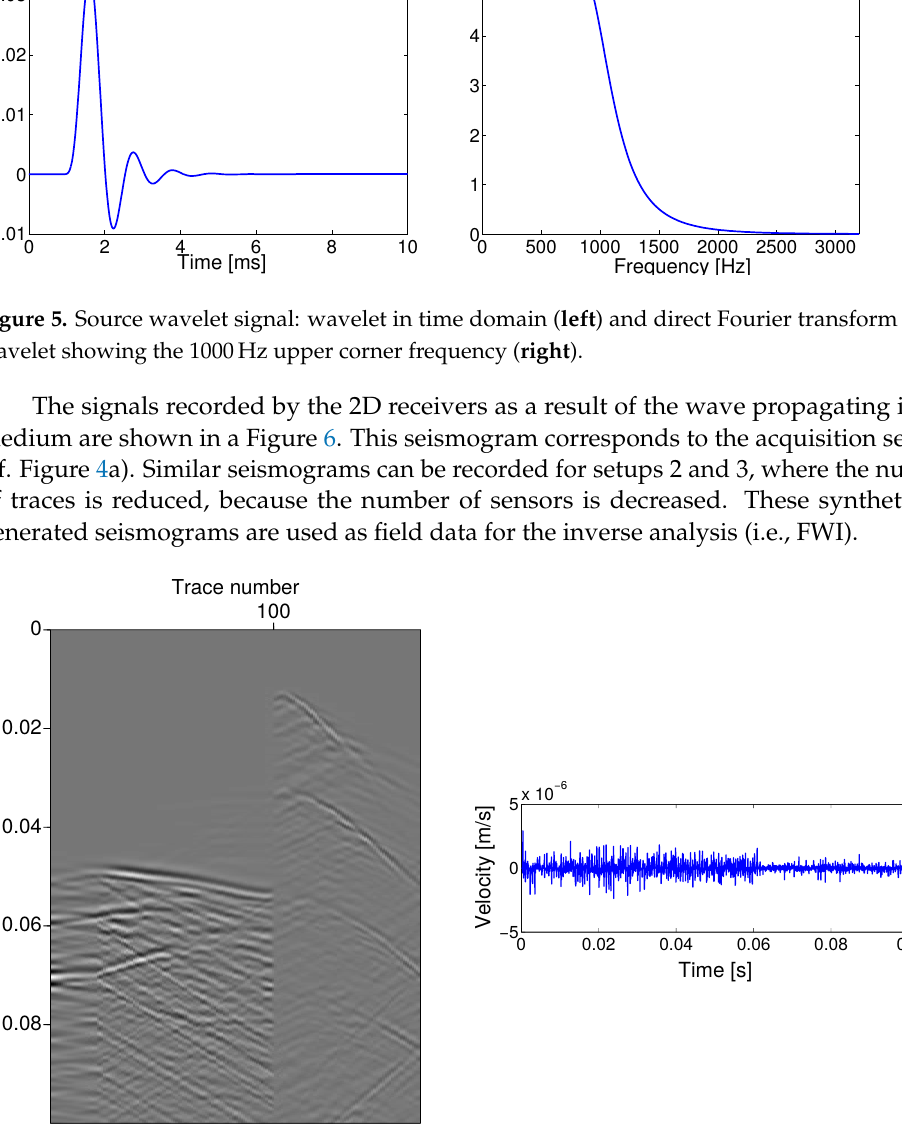
Figure 6. Sensor response due to propagated waves in medium. ( Left ): Seismogram of all 165 sensor response (i.e., trace) in x-direction as a result of wave propagation from source 14. Trace 100–165 corresponds to sensors on the reservoir bottom; thus, it picks up the waves first. ( Right ): Response of trace 53 located on the dam